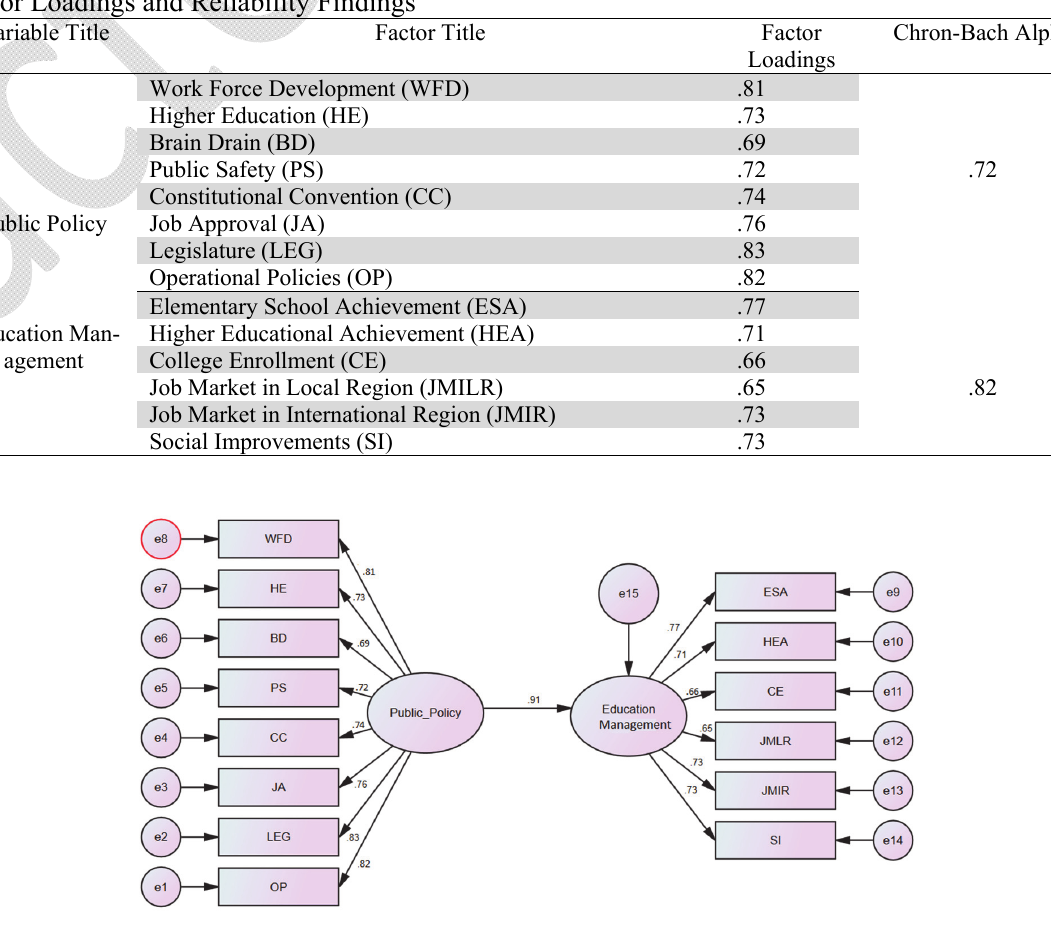
Fig. 2. Model Output for Public Policy and Education